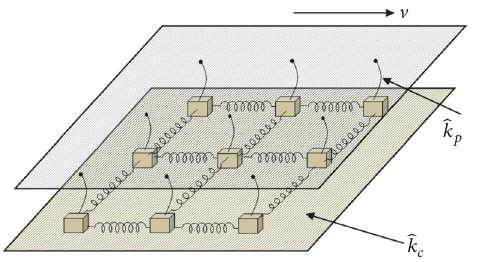
̂𝑘 𝑝 by a driver